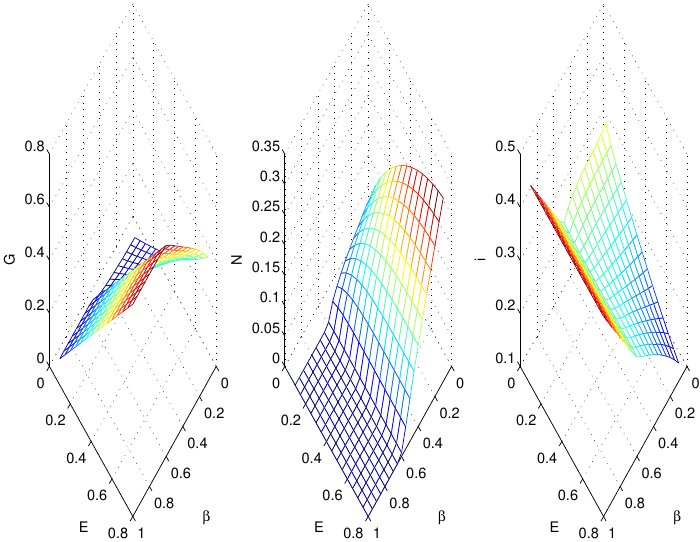
Figure 11. Coexistence sensitivity in terms of E and β . When both values of the parameters in their ranges are low, native squirrels can thrive, and prevalence is low; while the grey ones are reduced. Increasing the disease transmission rate soon leads to the native squirrel disappearance. This ecosystem behavior depends more on the values of β than on those of E